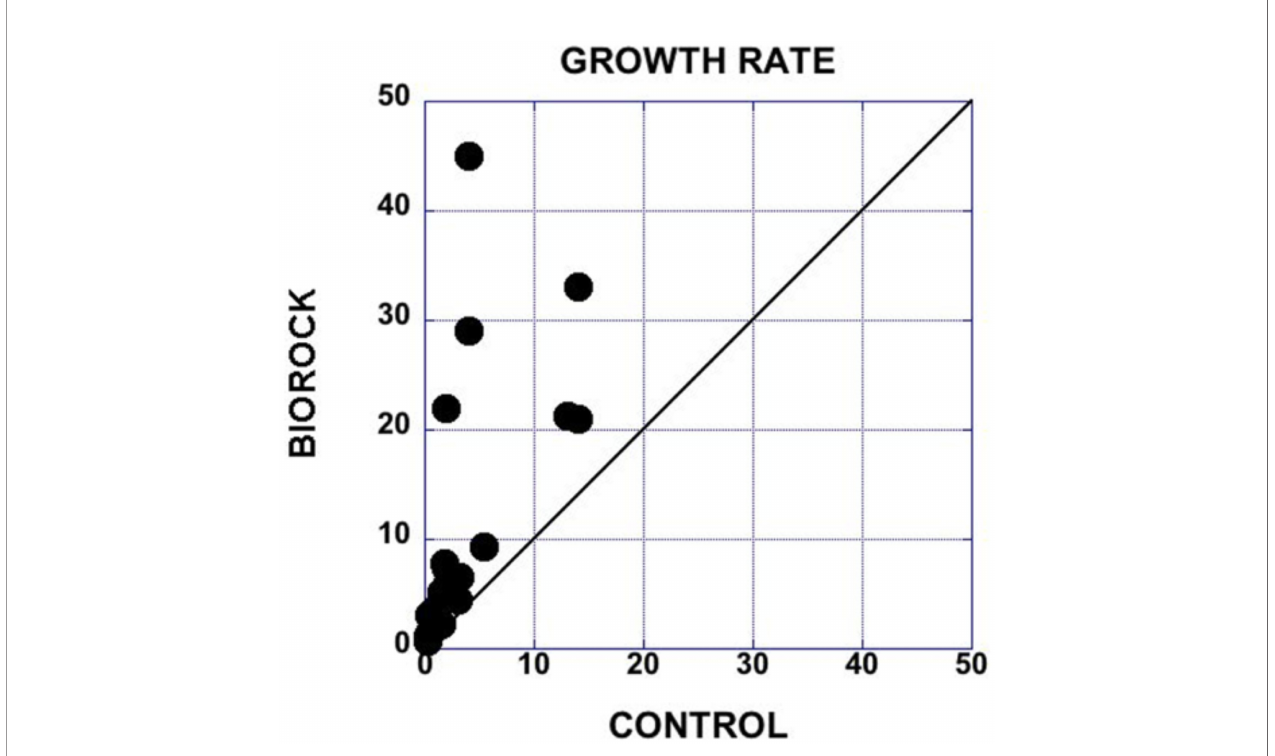
FIGURE 2 | Comparisons in growth rates between various species on Biorock versus controls. Each dot is a different species on a different Biorock reef under different conditions, from Goreau